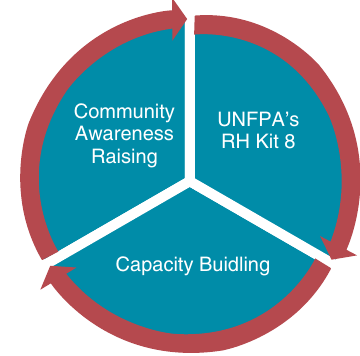
Figure 4. The RHCC